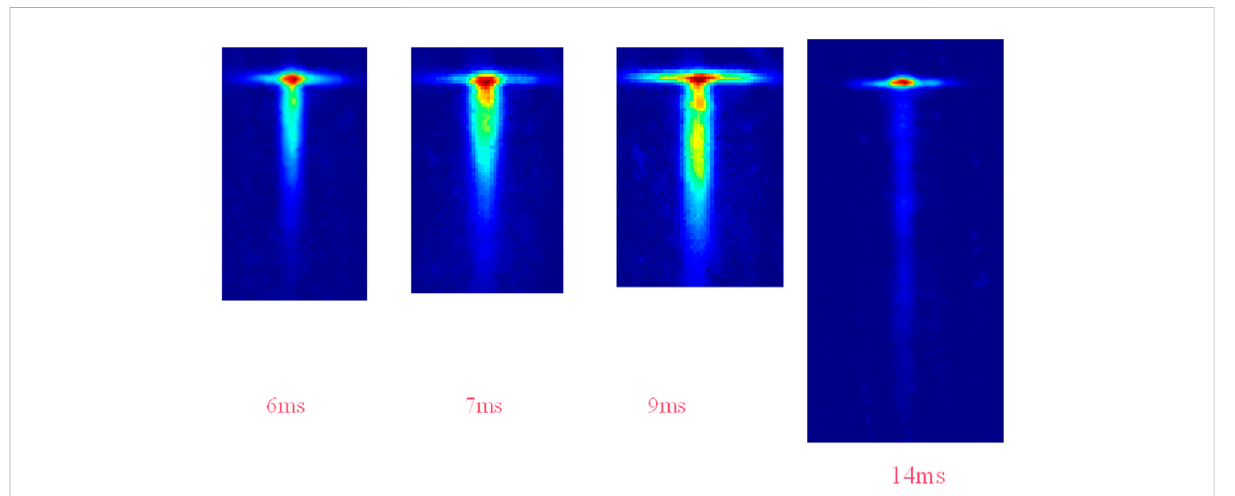
FIGURE 7 Atom laser at Peking University with different